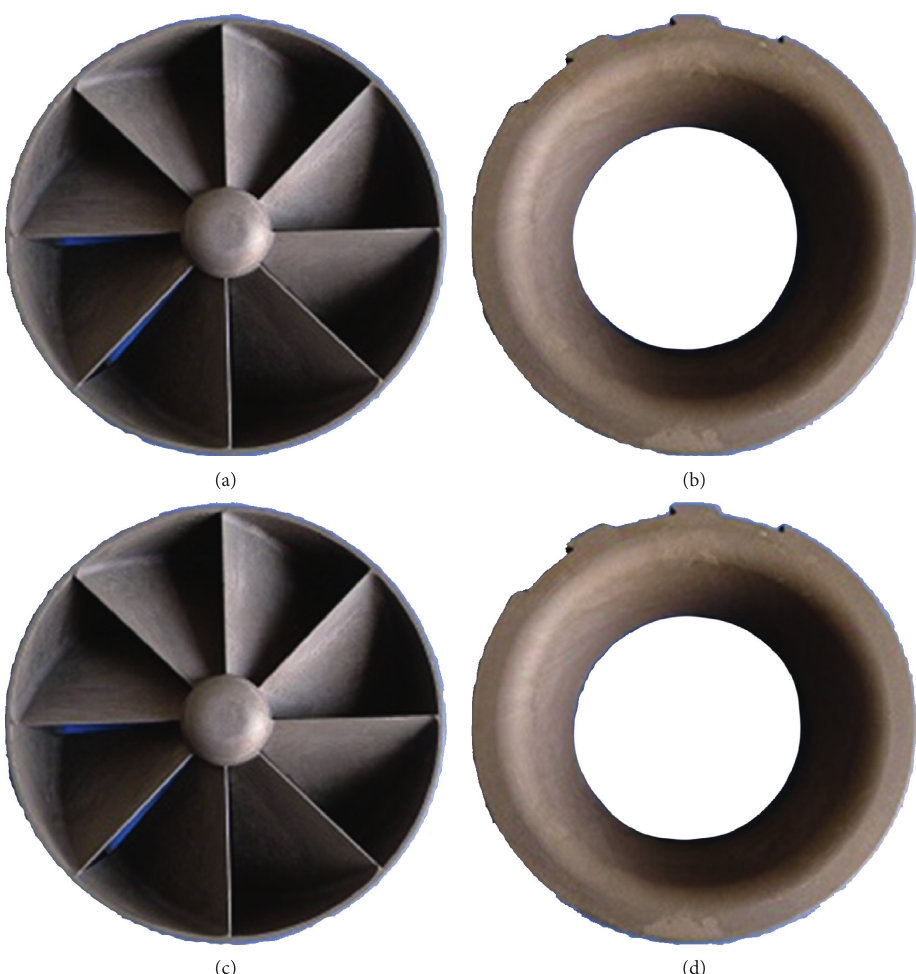
Figure 2: Marine cyclone separator structure sample by MAO and anodic oxidation: (a) MAO forward view; (b) MAO backward view; (c) anodic oxidation forward view; (d) anodic oxidation backward view.